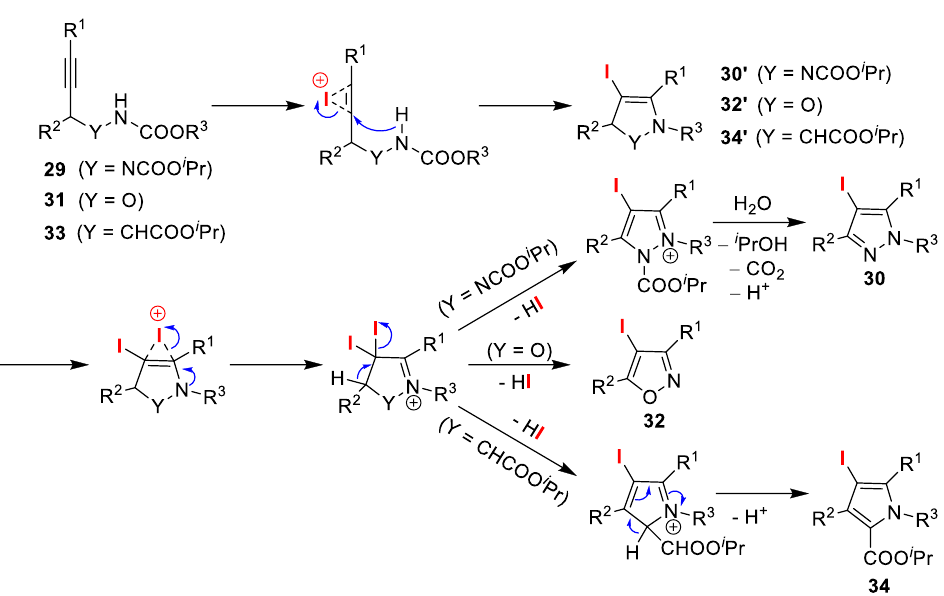
Figure 16. Selective syntheses of five-membered heterocycles via the iodo-cyclization of propargylic hydrazides 29 , N -alkoxycarbonyl propargylic hydroxylamines 31 ,and α -propargylic glycines 33 .